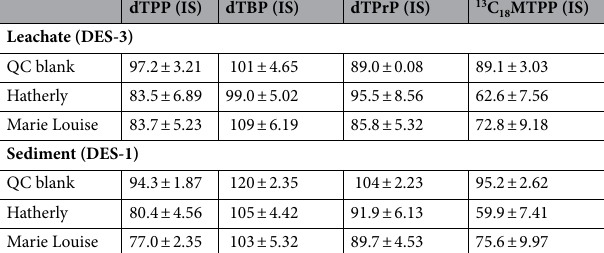
dTPP (IS) dTBP (IS) dTPrP (IS) 13 C 18 MTPP